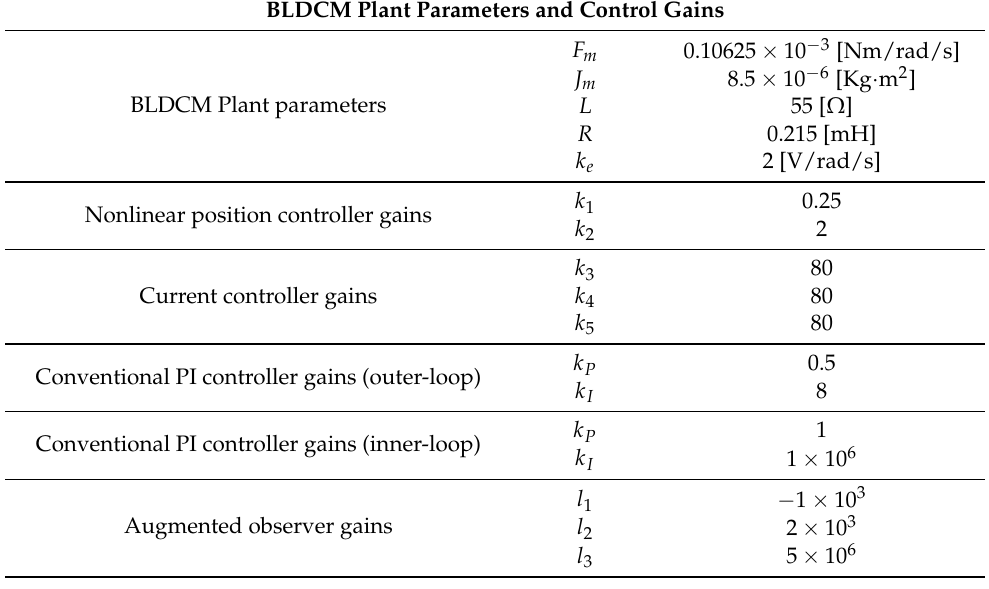
Table 1. BLDCM Plant parameters and control